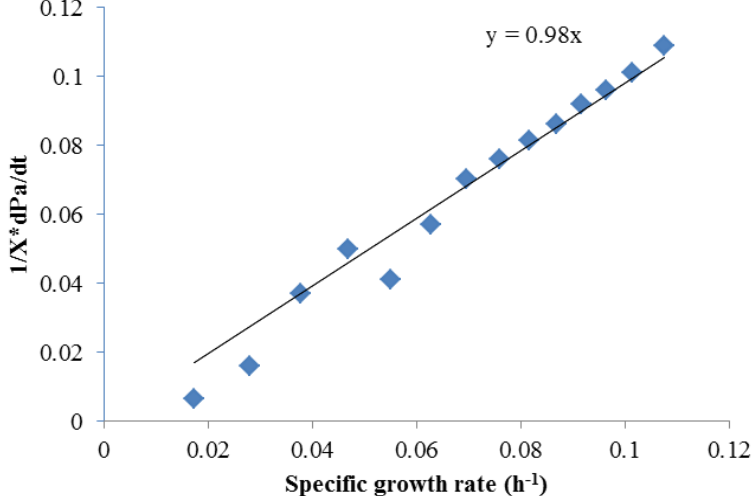
Figure 3. Specific rate of acetic acid formation as a function of specific cell growth rate for batch fermentation at pH